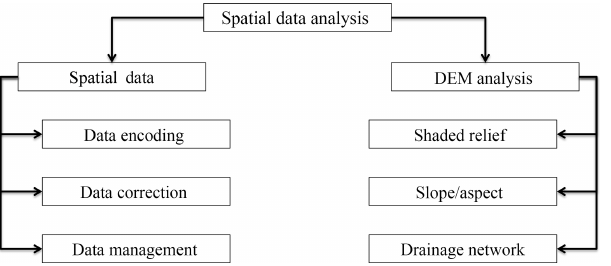
Figure 3. Workflow of spatial image